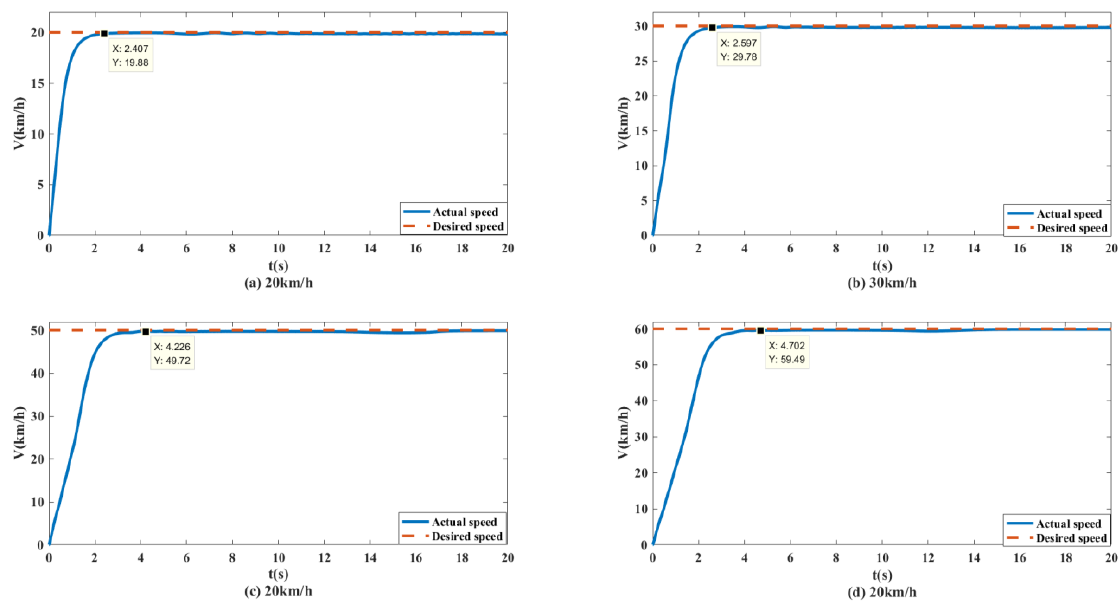
Figure 21. Speed tracking curves of unmanned vehicles at different speeds on the sine sweep straight road .